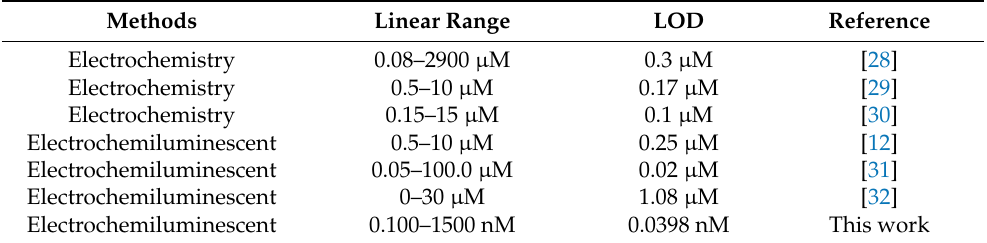
Figure 4. ( A ) ECL responses at different H 2 S concentrations: a–h: 0.100, 0.300, 1.00, 3.00, 10.0, 40.0, 200, 1500 nM; ( B ) relationship between ECL intensity and the logarithm of H 2 S concentrations. The error bars show the standard deviation of three replicate determinations. Table 1. Analytical performance of this biosensor in H 2 S detection compared with previously reported literature.